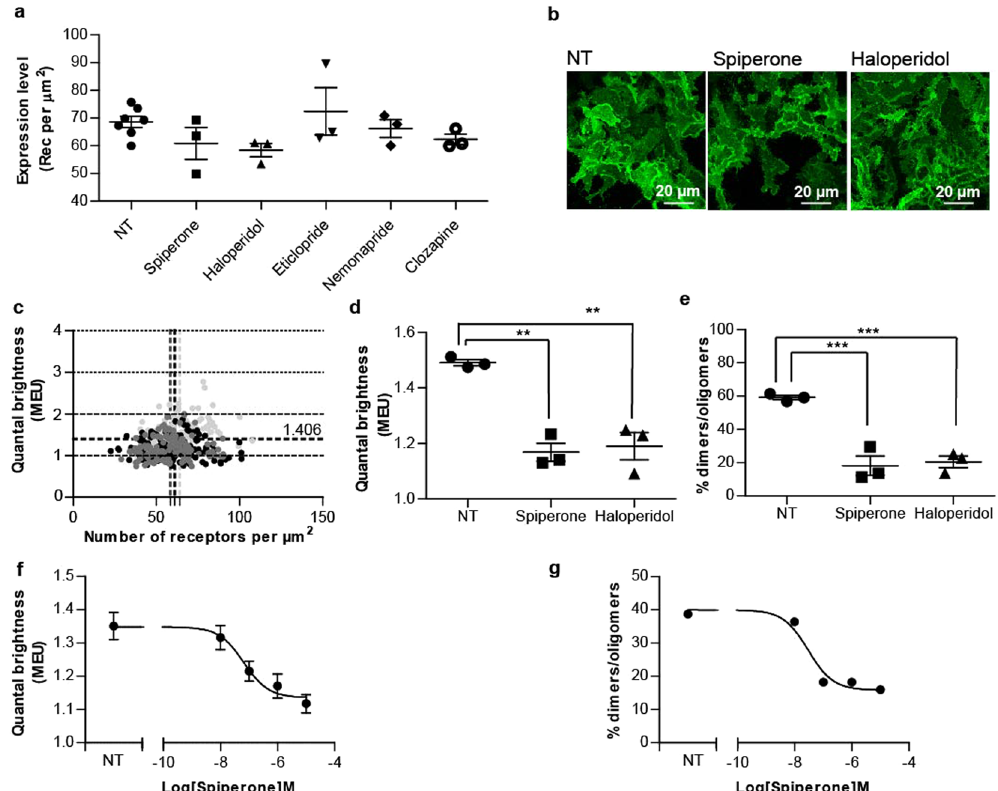
Figure 6. Antagonist treatment does not alter hD 3 R-mEGFP expression levels but spiperone and haloperidol decrease receptor quaternary complexity. Flp-In T-REx 293 hD 3 R-mEGFP clone 2 cells were not treated (NT) or treated with spiperone (10 µ M), haloperidol (10 µ M), eticlopride (10 µ M), nemonapride (10 µ M) or clozapine (20 µ M) for 16 h. ( a ) Fluorescence intensity analysis of the basolateral membrane of the untreated cells indicated hD 3 R-mEGFP to be expressed at 68.6 ± 2.0 receptor per µ m 2 and that treatment with the various antagonists did not significantly alter cell surface expression level. Combined data from n = 10 × 44 experiments × observations (NT) and 3 × 44 (each antagonist), with the average value from each experiment shown, error bars represent ± S.E.M. ( b ) Confocal images from the basolateral membrane of cells not treated (NT) or treated with spiperone or haloperidol were collected with laser power set at 6%. Scale bar = 20 µ m. ( c ) QB MEU were assessed in individual RoI and plotted against the number of hD 3 R-mEGFP per µ m 2 at the cell surface. Light grey circles , untreated cells; dark grey circles , cells treated with haloperidol; Black circles , cells treated with spiperone. ( d ) Quaternary arrangement of hD 3 R-mEGFP receptor expressed as QB MEU value in not treated cells (1.49 ± 0.01) and cells treated with spiperone (1.17 ± 0.03) or haloperidol (1.19 ± 0.05). Combined data from n = 3 × 44 measurements, error bars represent ± S.E.M. ** p < 0.01 when compared to not treated. ( e ) Assessment of percentage of RoIs containing predominantly dimers/oligomers in untreated (59.1 ± 1.3%) or treated with spiperone (18.2 ± 5.7%) or haloperidol (20.5 ± 3.5%). Combined data from n = 3 × 44 experiments, error bars represent ± S.E.M., *** p < 0.001 when compared to not treated cells. ( f ) QB MEU mean values were plotted against spiperone concentration. Combined data from n = 44 measurements, error bars represent ± S.E.M. ( g ) The percentage of RoI containing predominantly dimers/oligomers was calculated and plotted against spiperone